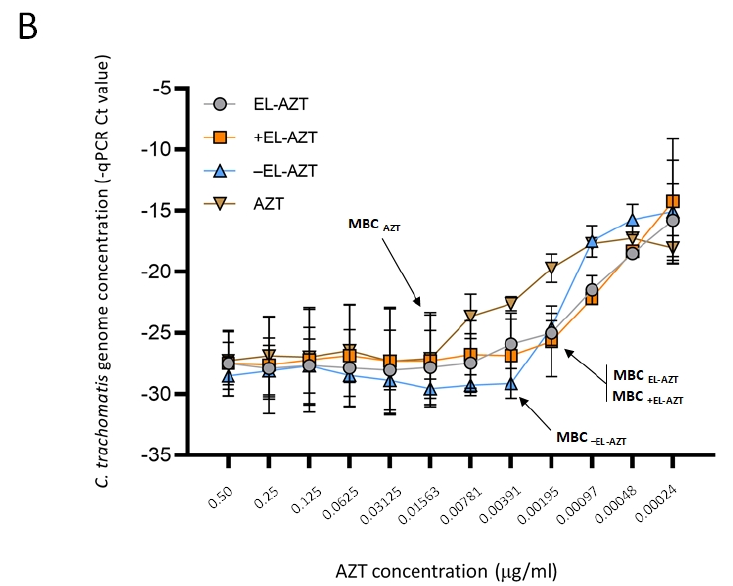
Figure 6. Impact of different types of AZT-liposomes on the growth of C. trachomatis serovar D. ( A ) Direct C. trachomatis growth in the presence of free AZT and liposomally-encapsulated AZT. ( B ) Recoverable C. trachomatis growth. Data are mean − qPCR Ct levels ± S.D. ( n = 3). EL-AZT, neutral liposomes with azithromycin; +EL-AZT, cationic liposomes with azithromycin; − EL-AZT, anionic liposomes with azithromycin.